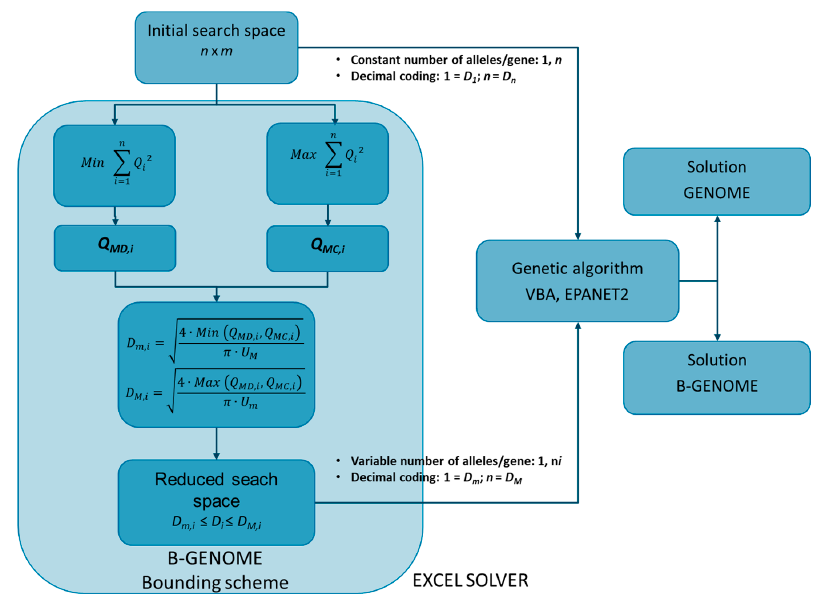
Figure 1. Flowchart of the proposed model.